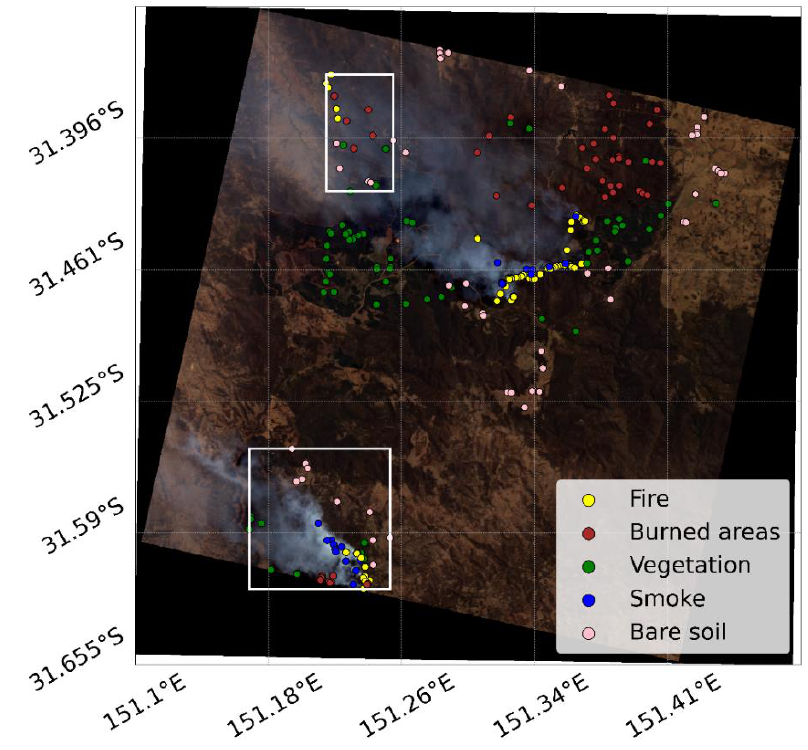
Figure 3. The RGB PRISMA composite image with labelled points defined for the five classes. Pixels within the white rectangles are used for the test, the others for training and